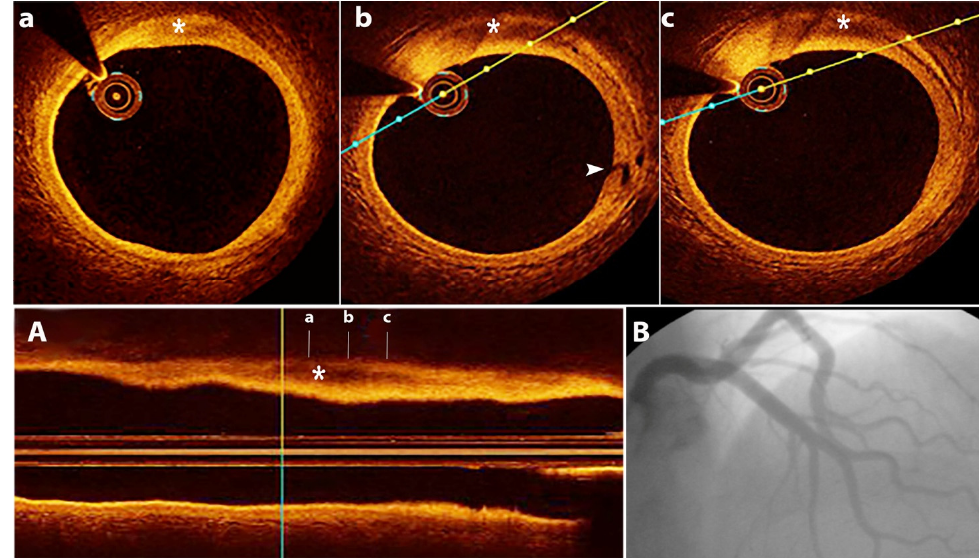
Figure 3. SCAD in a 41 years old male patient with anterior ST segment elevated myocardial infarction. ( A )—OCT—longitudinal view—in wall hematoma (asterisk); ( B )—normal coronary arteries on angiography; ( a – c )—OCT—transversal views—SCAD—in wall hematoma (asterisk)— dissection entry point (white arrowhead in ( b )).